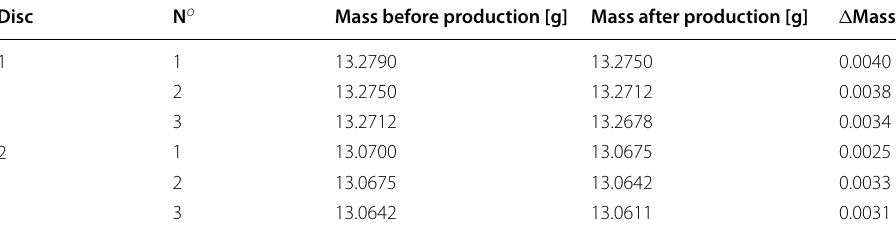
Table 1 The target masses (with platinum disc) before and after the subsequent three bombardments as well as the corresponding mass losses for the irradiated discs 1 and 2 Disc N o Mass before production [g] Mass after production [g] (cid:31) Mass